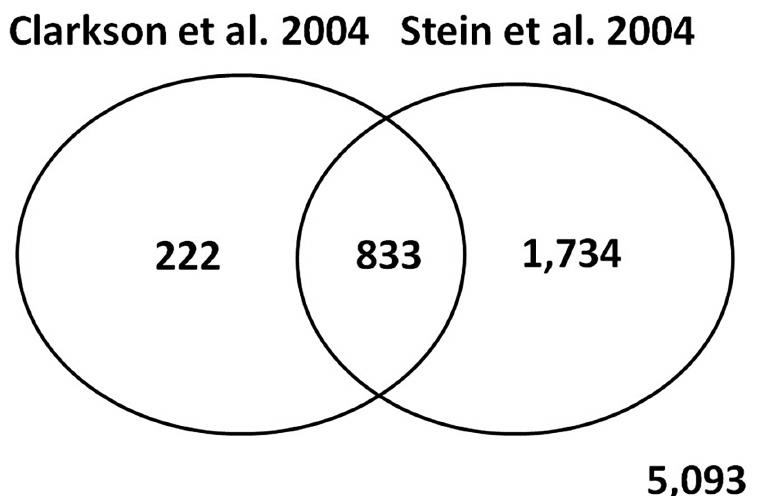
Fig 1. Venn diagram showing the overlap and discrepancies between genes differentially expressed in Clarkson et al. [3] and Stein et al. [4].